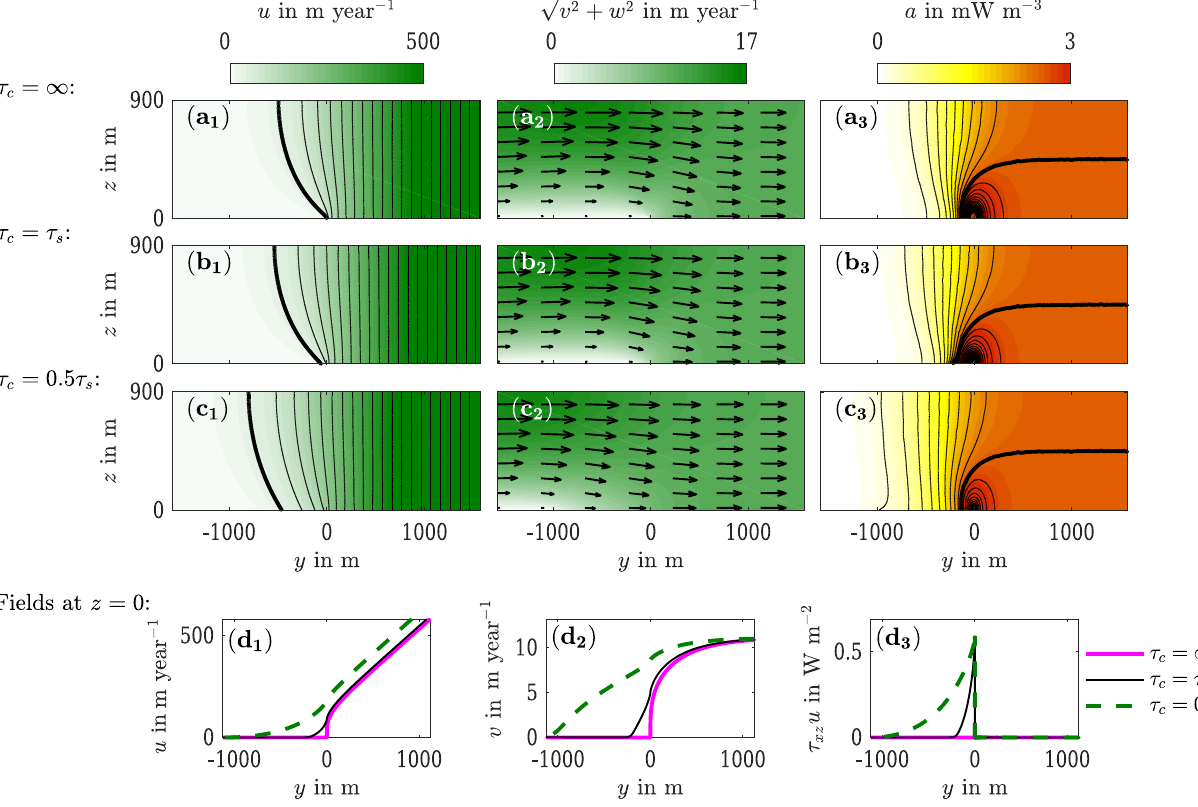
Figure 2. Influence of the subtemperate yield stress τ c on the mechanical fields in the ice stream margin. τ s is the lateral shear stress in the margin. Rows of panels are labeled ( a – d ), with suffixes 1–3 indicating columns. Panels ( a 1 – c 1 ): contours of downstream velocity component u at contour intervals of 40myr − 1 ; bold line indicates u = 40myr − 1 . Panels ( a 2 – c 2 ): transverse velocity field (v,w) shown as arrows; shading indicates magnitude of the transverse velocity. Panels ( a 3 – c 3 ): contours of heat production a at contour intervals 2 . 6 × 10 − 4 Wm − 3 , a = 2 . 56 × 10 − 3 Wm − 3 shown as a bold line. Panels ( d 1 – d 3 ) show the velocities and heat dissipation at the bed. Note that no heat is dissipated at the bed where the velocities are zero. Calculations were done with the values listed in Table 1 and τ c as